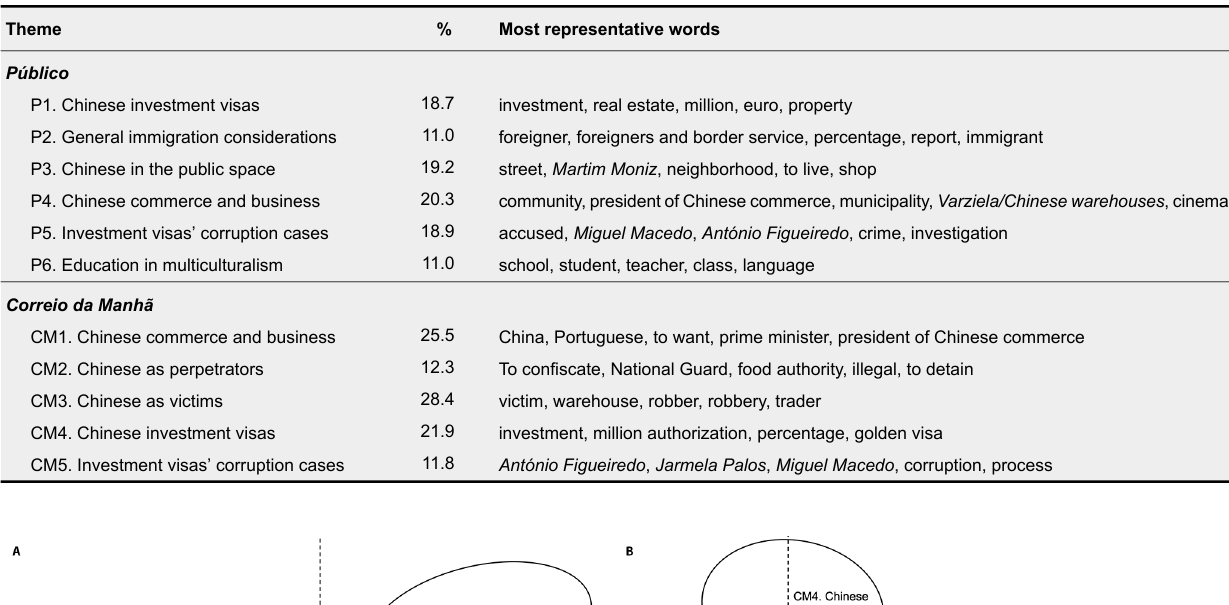
Themes Organising the Articles in Público and Correio da Manhã